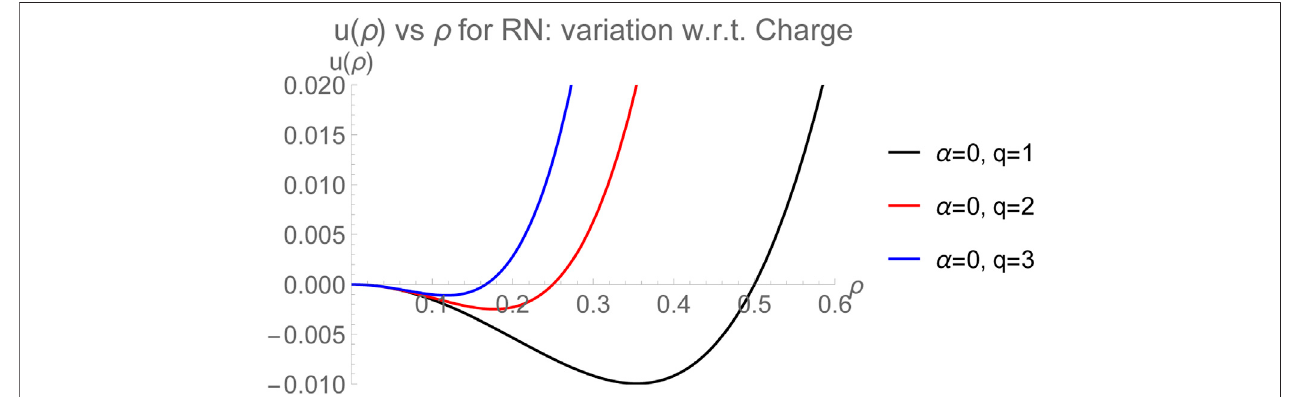
FIGURE 7 | Mean fi eld interaction potential u ( ρ ) as a function of ρ for various values of electric charge q with α (cid:2)